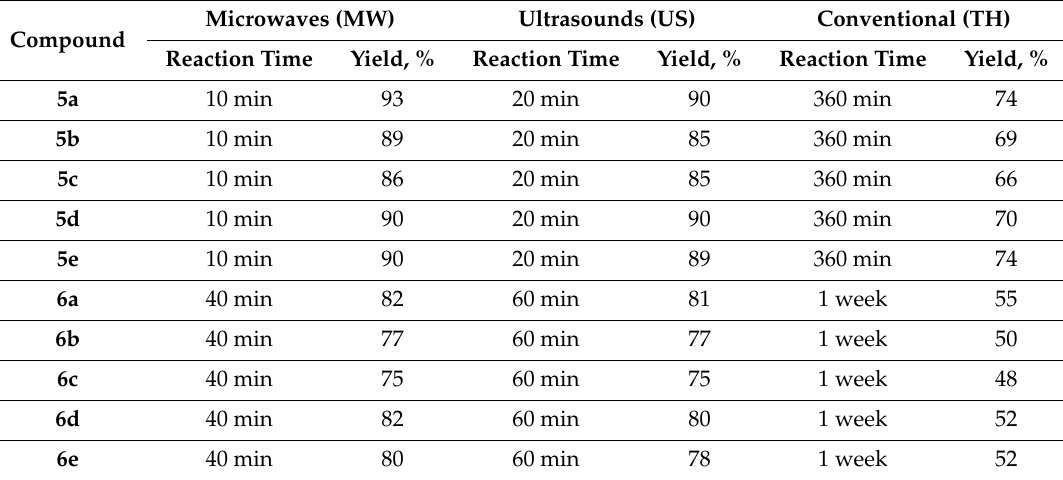
Table 1. The best results obtained in the synthesis of pyrrolo[2,1-a]phthalazine derivatives with optimized reaction conditions under MW and US irradiation and conventional TH.